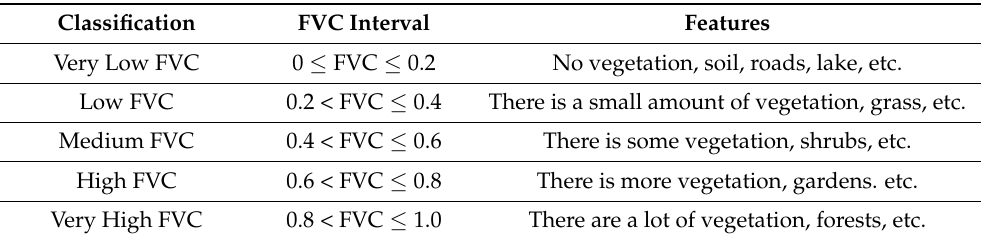
Table 1. Classification of vegetation coverage given FVC values in built-up areas of provincial capital cities. Classification FVC Interval Features Very Low FVC 0 ≤ FVC ≤ 0.2 No vegetation, soil, roads, lake, etc. Low FVC 0.2 < FVC ≤ 0.4 There is a small amount of vegetation, grass, etc. Medium FVC 0.4 < FVC ≤ 0.6 There is some vegetation, shrubs, etc. High FVC 0.6 < FVC ≤ 0.8 There is more vegetation, gardens. etc. Very High FVC 0.8 < FVC ≤ 1.0 There are a lot of vegetation, forests,